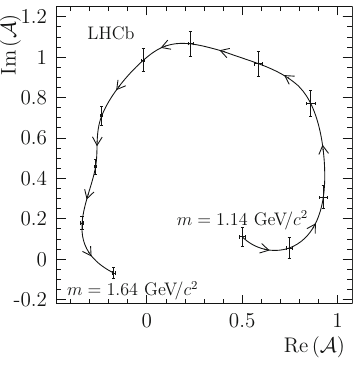
Fig. 3 Argand diagram for the model-independent partial-wave anal- ysis (MIPWA) for the K ( 1460 ) resonance. Points show the values of the amplitude that are determined by the fit, with only statistical uncer- tainties shown